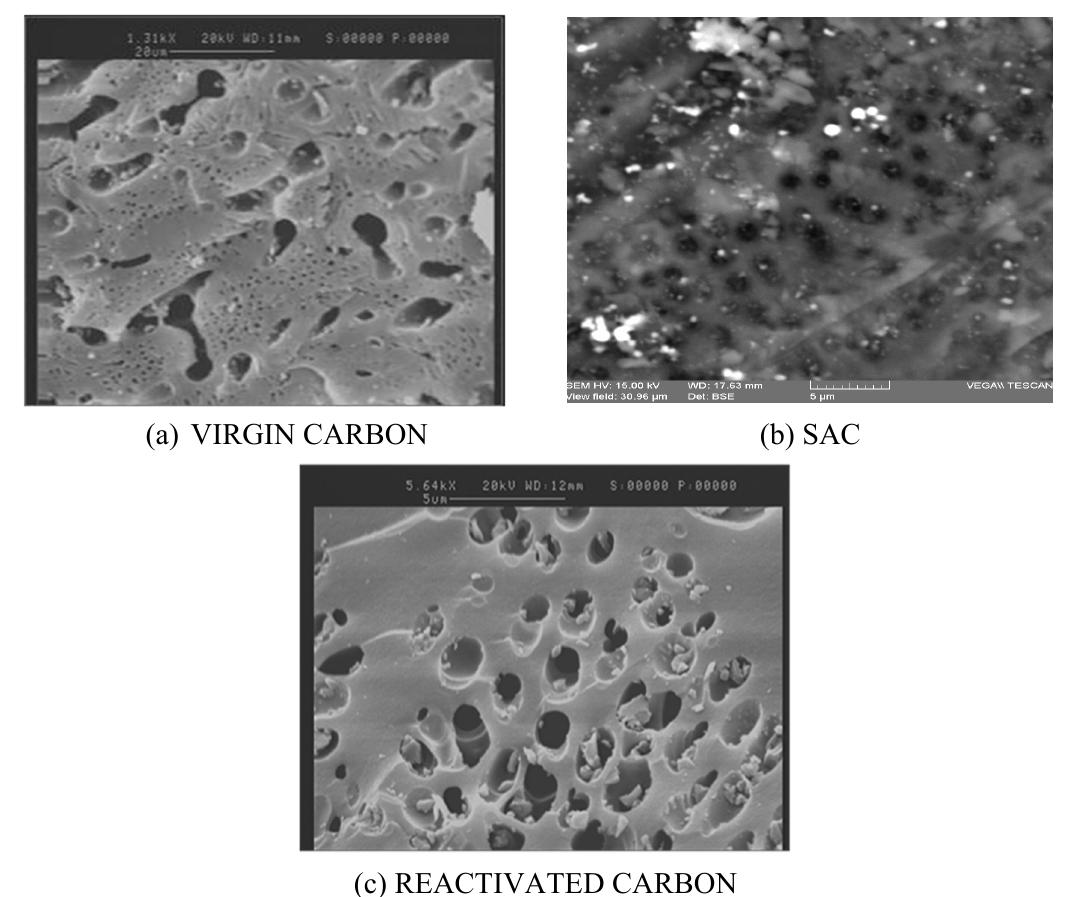
Figure 7. Scanning electron microscopy (SEM) images of ( a ) virgin carbon, ( b ) SAC, and ( c ) reactivated carbon. This image has been modified in order to highlight the deposits of calcium (on lighter color) on the surface. Reactivation conditions: acid-wash HNO 3 20% v / v at 50 °C and thermal reactivation at 850 °C and 1 h.